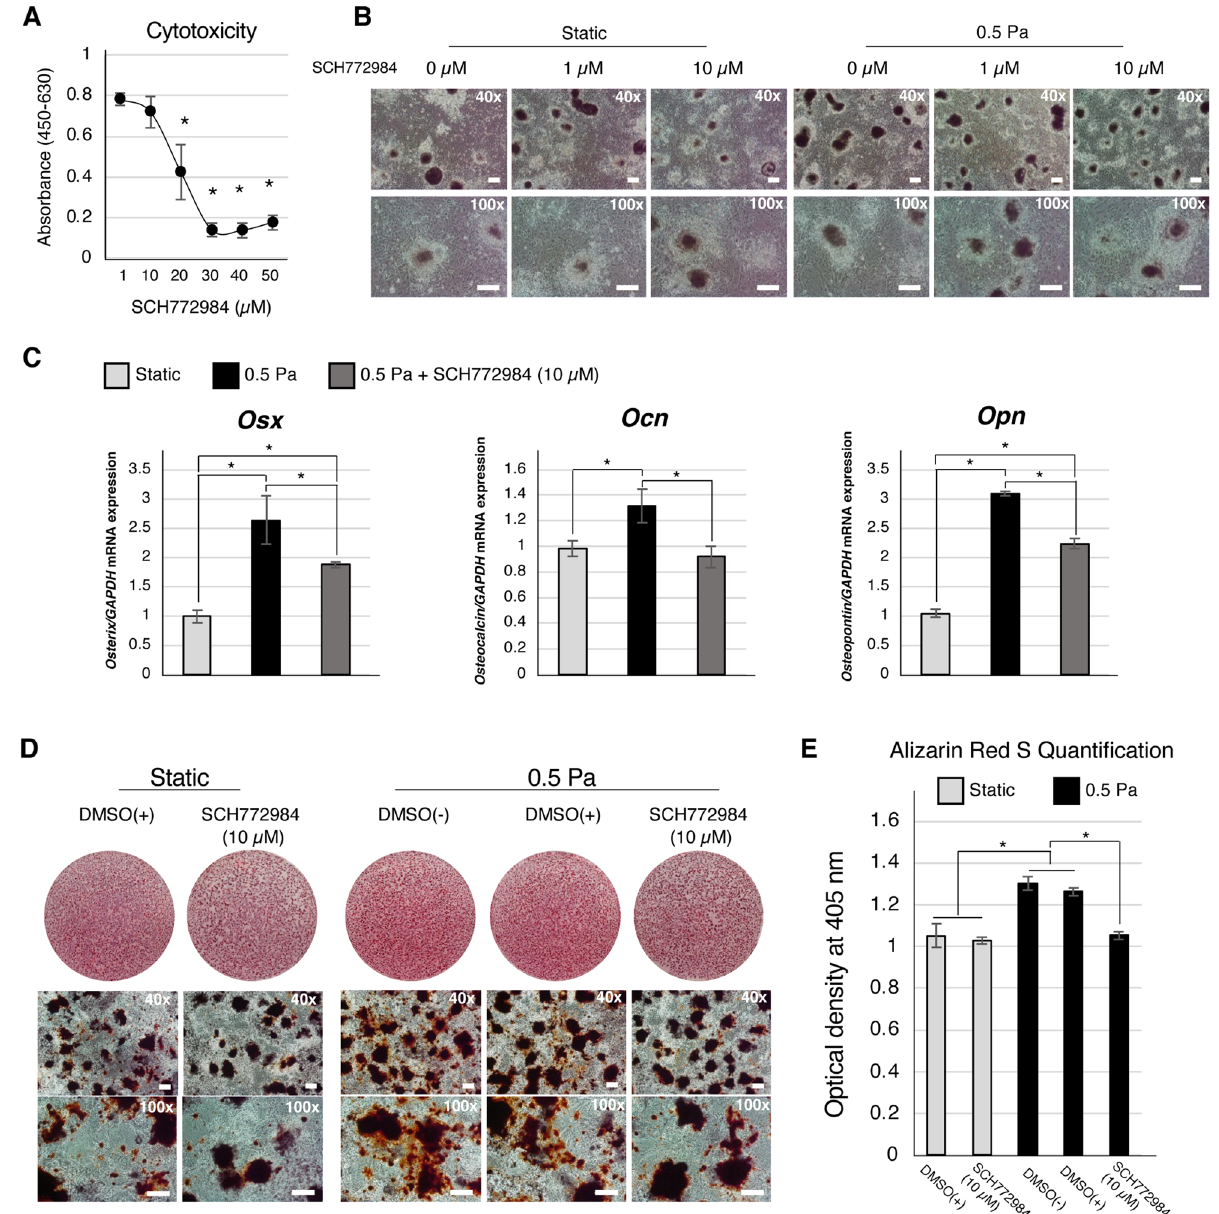
Figure 5. Inhibition of Erk1/2 activity suppressed the shear-stress enhanced-osteogenic differentiation of iPSCs. ( A ) WST-1 assay was performed to evaluate the cytotoxic effects of Erk1/2 phosphorylation inhibitor SCH772984 at various concentrations. *: P < 0.05, ANOVA with Dunnett’s correction for multiple comparisons. Representative data from three independent experiments are shown (mean values ± SD: n = 3). (B ) Morphology and viability of osteogenically-induced iPSCs were observed under a phrase-contrast microscope. The magnifications of upper and lower panels are 40× and 100×, respectively. Scale bars: 200 μm. ( C ) Real-time RT-PCR analysis was performed to evaluate the expression of osteogenic genes ( Osx , Col1a1 , Ocn , and Opn ). *: P < 0.05, ANOVA with Tukey’s multiple comparison test. Representative data from three independent experiments are shown (mean values ± SD: n = 3). ( D ) Alizarin Red S staining was performed to evaluate mineral deposits. After treatment with inhibitor during the application of 0.5 Pa shear force application, the cells were maintained in osteogenic induction medium for another five days prior to Alizarin Red S staining. The magnifications of upper and lower panels are 40× and 100×, respectively. Scale bars: 200 μm. ( E ) Quantitative analysis of Alizarin Red S staining. *: P < 0.05, ANOVA with Tukey’s multiple comparison test. Representative data from three independent experiments are shown (mean values ± SD: n =